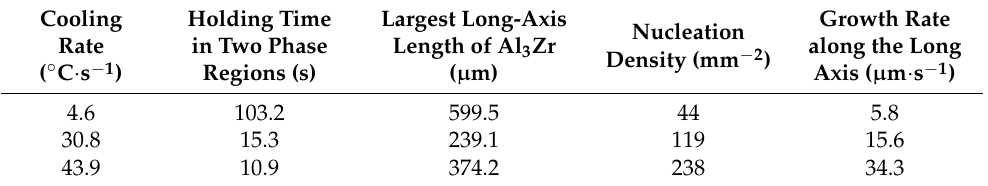
Table 2. Nucleation density and growth rate of Al 3 Zr phases during solidifications at 1320 ◦